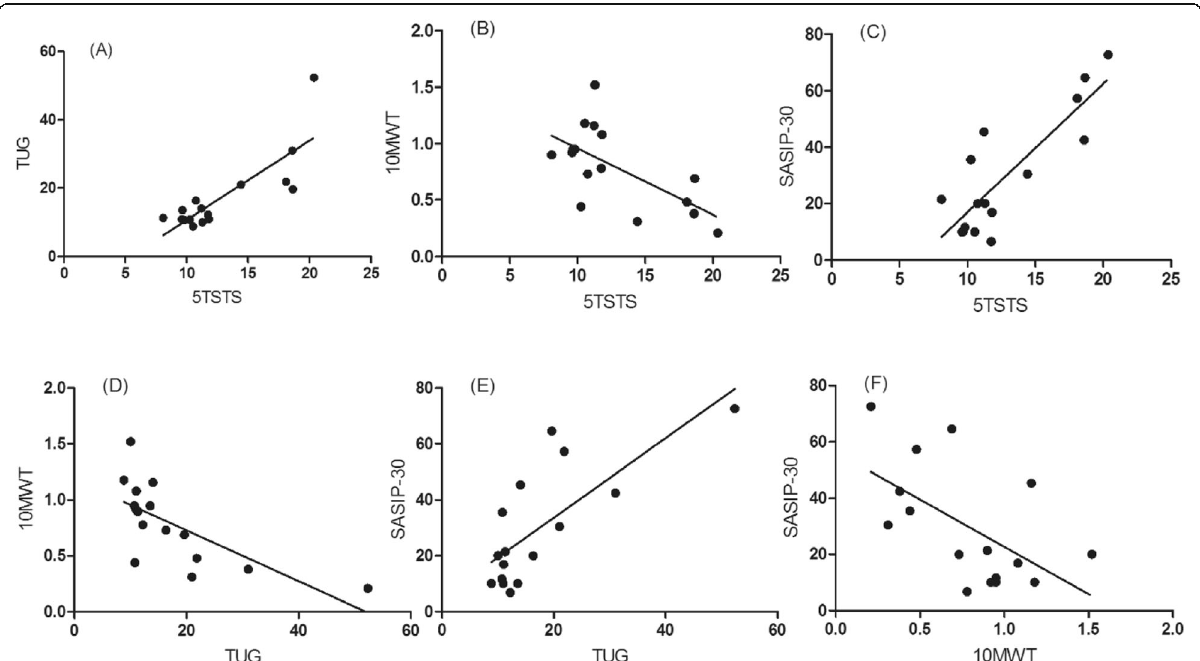
Fig. 1 Scatter plots shows correlation between variables. ( A ) TUG vs 5TSTS, ( B ) 10MWT vs 5TSTS, ( C ) SASIP-30 vs 5TSTS, ( D ) 10MWT vs TUG, ( E ) SASIP-30 vs TUG, ( F ) SASIP-30 vs 10 MWT. 5TSTS, five times sit to stand; TUG, timed up and go test; 10MWT, 10-m walk test; SASIP-30, Stroke Adapted Sickness Impact